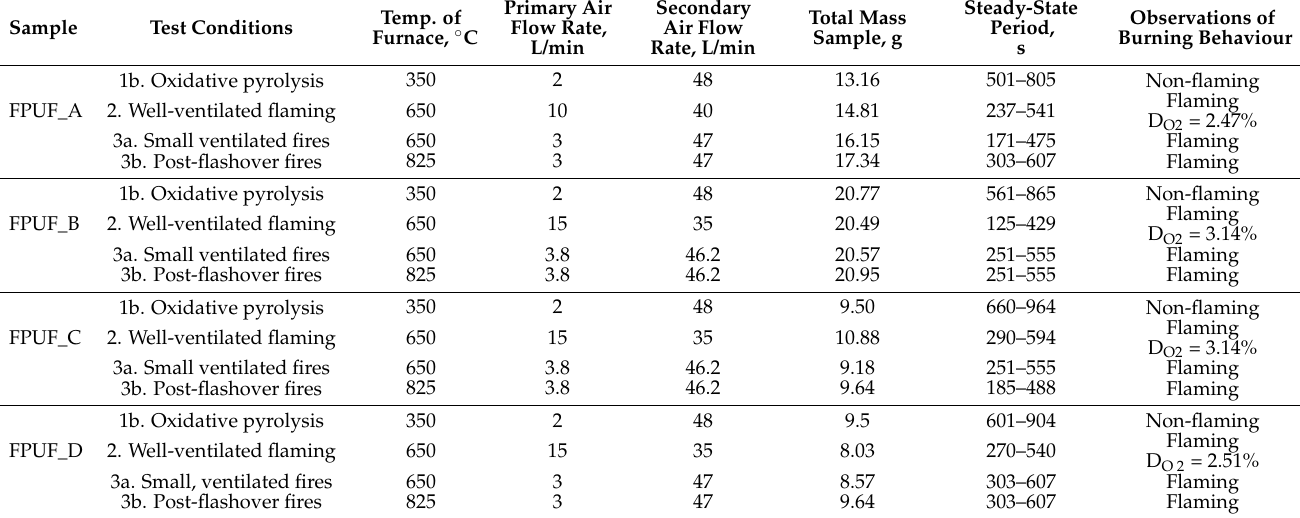
Table 4. Steady-state tube furnace test data for flexible polyurethane